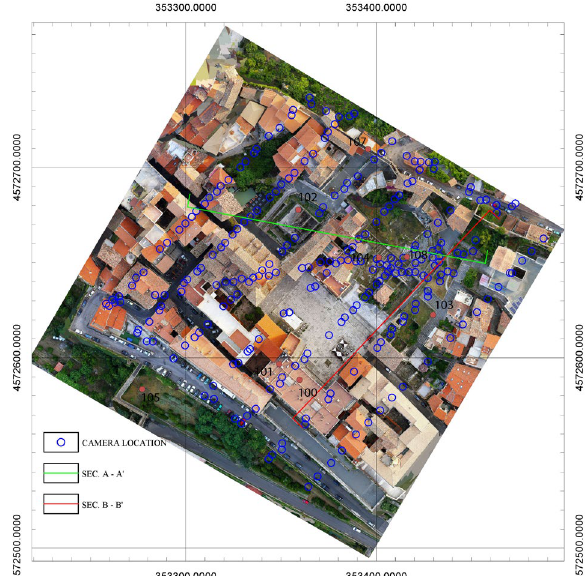
Figure 3: Orthophoto, photogrammetric shots (blue), lines sections (green and red), GCPs and CPs